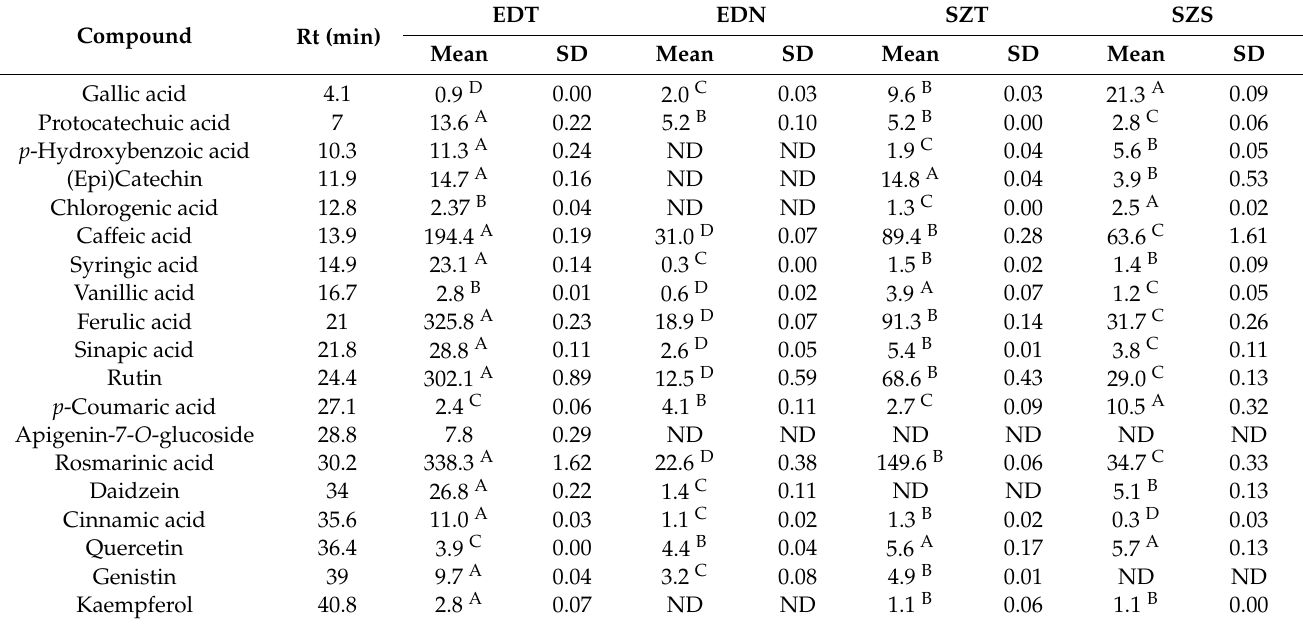
Table 2. Phenolic compound contents (ug/g) of Egyptian dukkah and Syrian